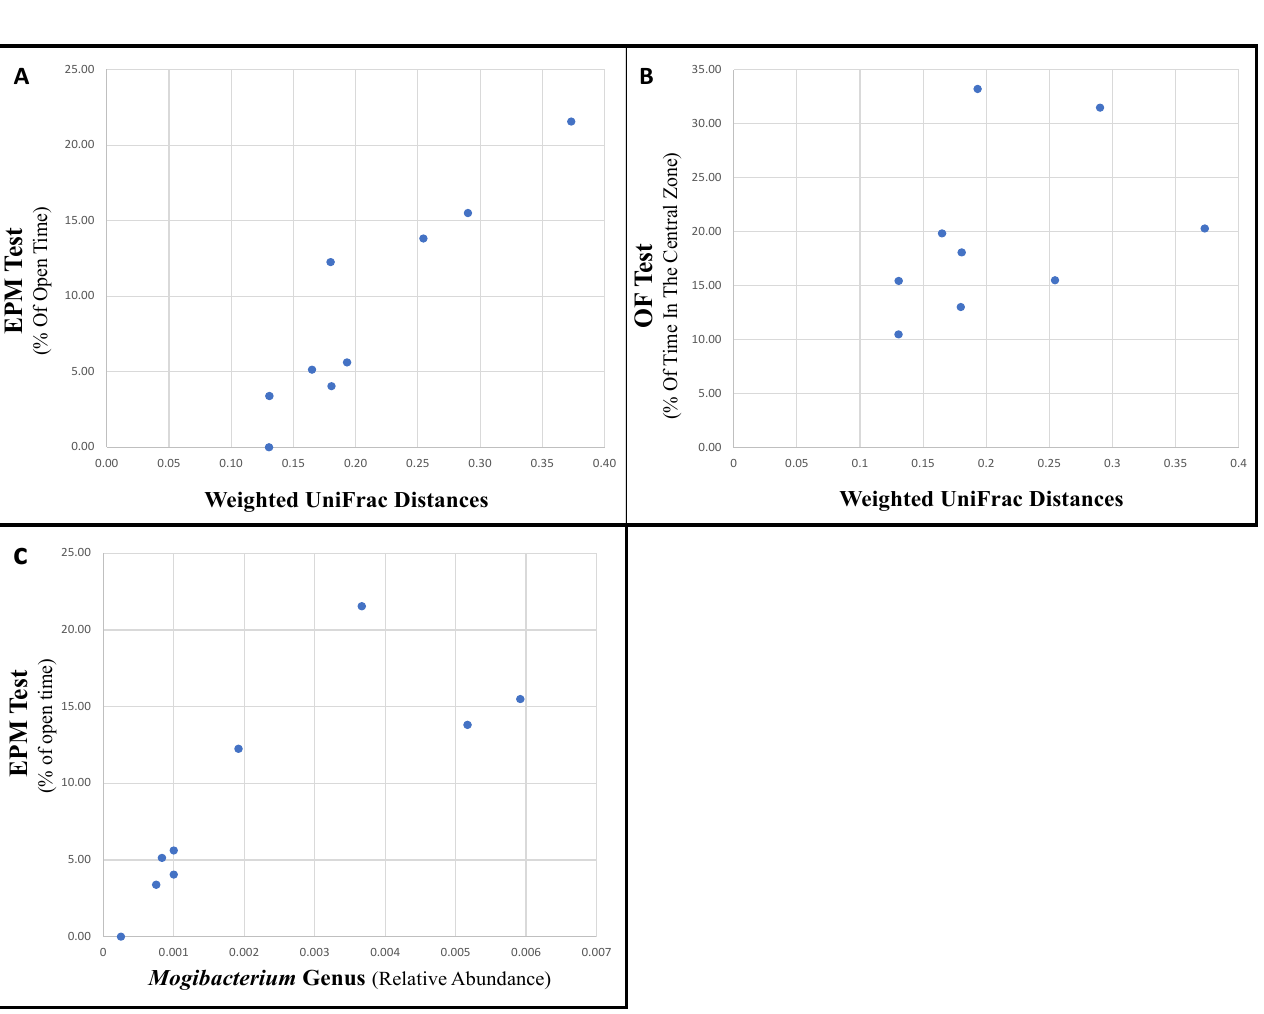
Figure 5. Correlation of behavioral test scores with microbiota parameters in oxytocin-treated rats. The cage mean behavioral tests score was used. Spearman’s correlation values: ( A ) weighted UniFrac Distance and EPM test, p = 0.001, R = 0.92; ( B ) weighted UniFrac Distance and OF test, p = 0.04, R = 0.7; ( C ) relative abundance of Mogibacterium and EPM, p = 0.001, R = 0.92.